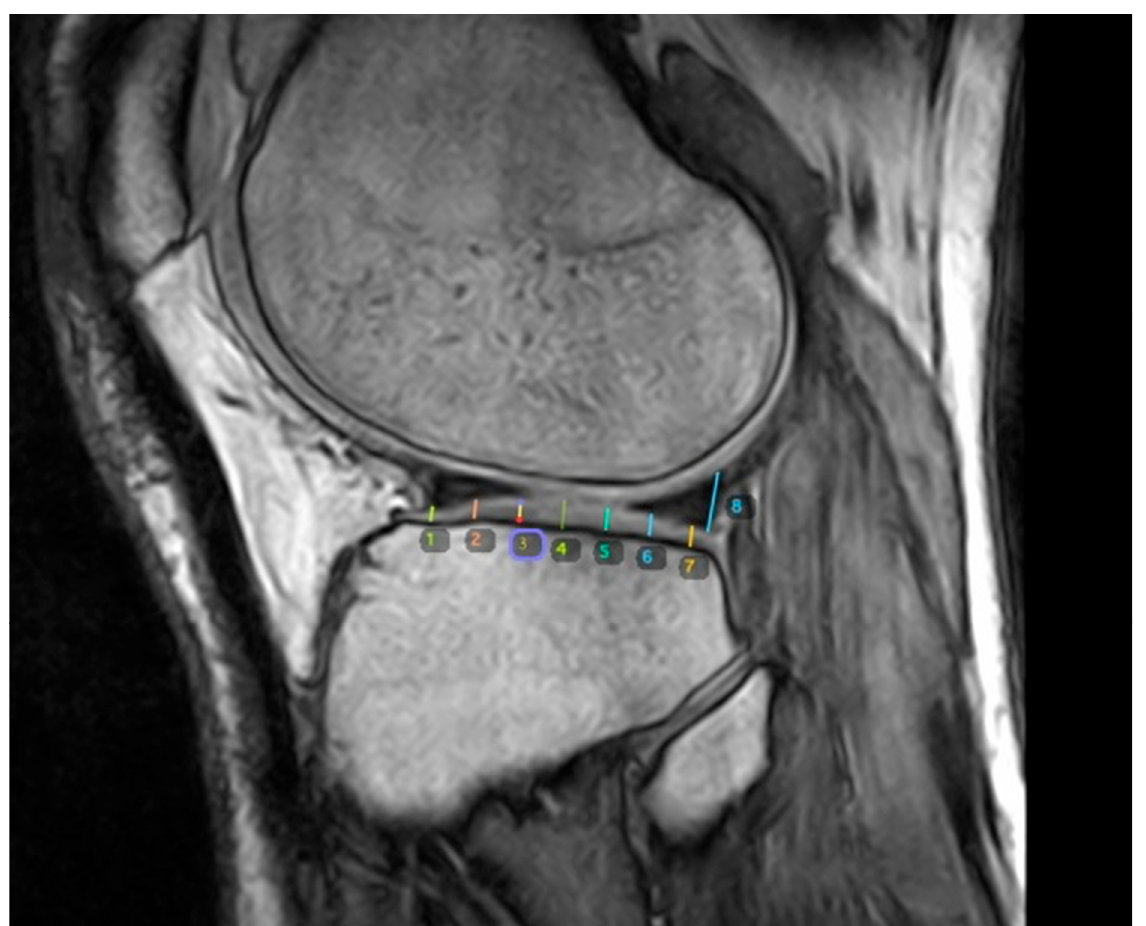
Figure 4. The plane and points of measurements for tibial condyles in the sagittal plane; the condyle was divided (in AP dimension of the condyle) into eight equal sections marking seven cartilage measurement points.